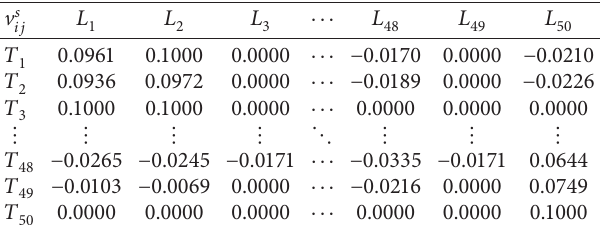
Table 18: Comprehensive perceived utility matrix V ′ � [ v s landlords.